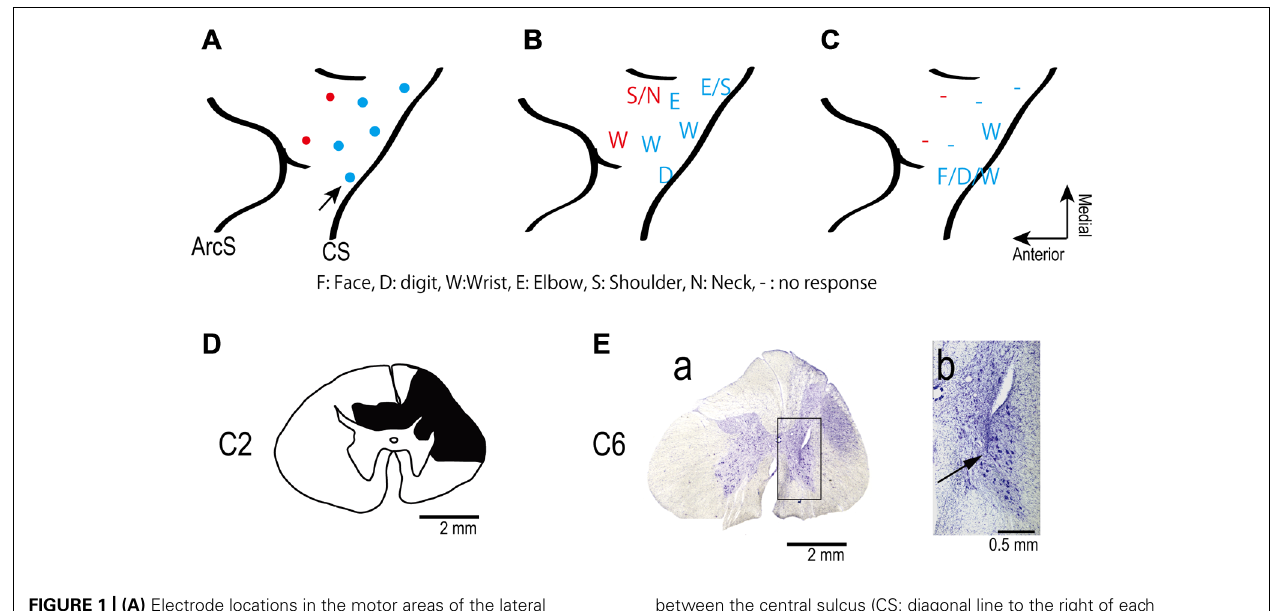
between the central sulcus (CS: diagonal line to the right of each panel) and the arcuate sulcus (ArcS: curved line to the left). Arrow indicates site used in session illustrated in Figure 3 . (D) Drawing of the C2 segments showing the extent of the spinal cord lesion (hatched in black). (E) Electrode location in spinal cord. (a) Electrodes were targeted at the ventral horn and intermediate zone of the spinal cord. (b) Higher magnification view of the location of an electrode tip (black